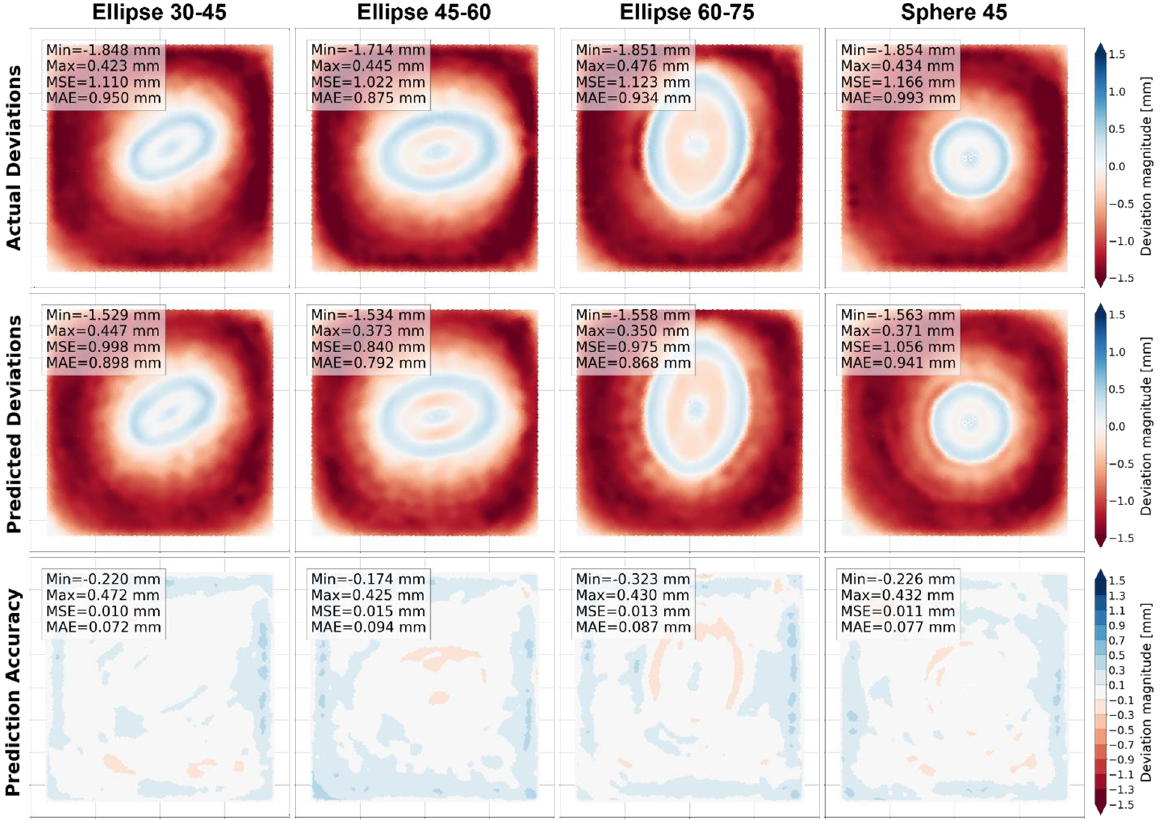
Figure 4. Prediction of deviations of SPIF output for four new test geometries (see Table 3). Shown deviation magnitudes are calculated normal to CAD geometry.